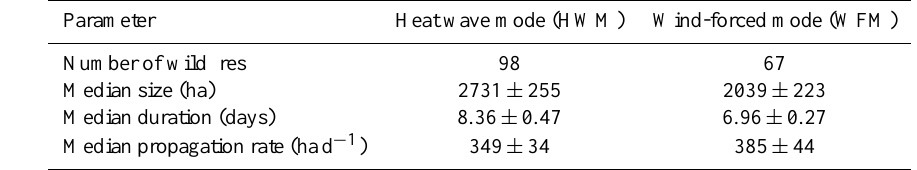
Table 1. Table of median BA values, duration and propagation rate of HWM and WFM wildfires. We take only the wildfires with a size in the top 10%.